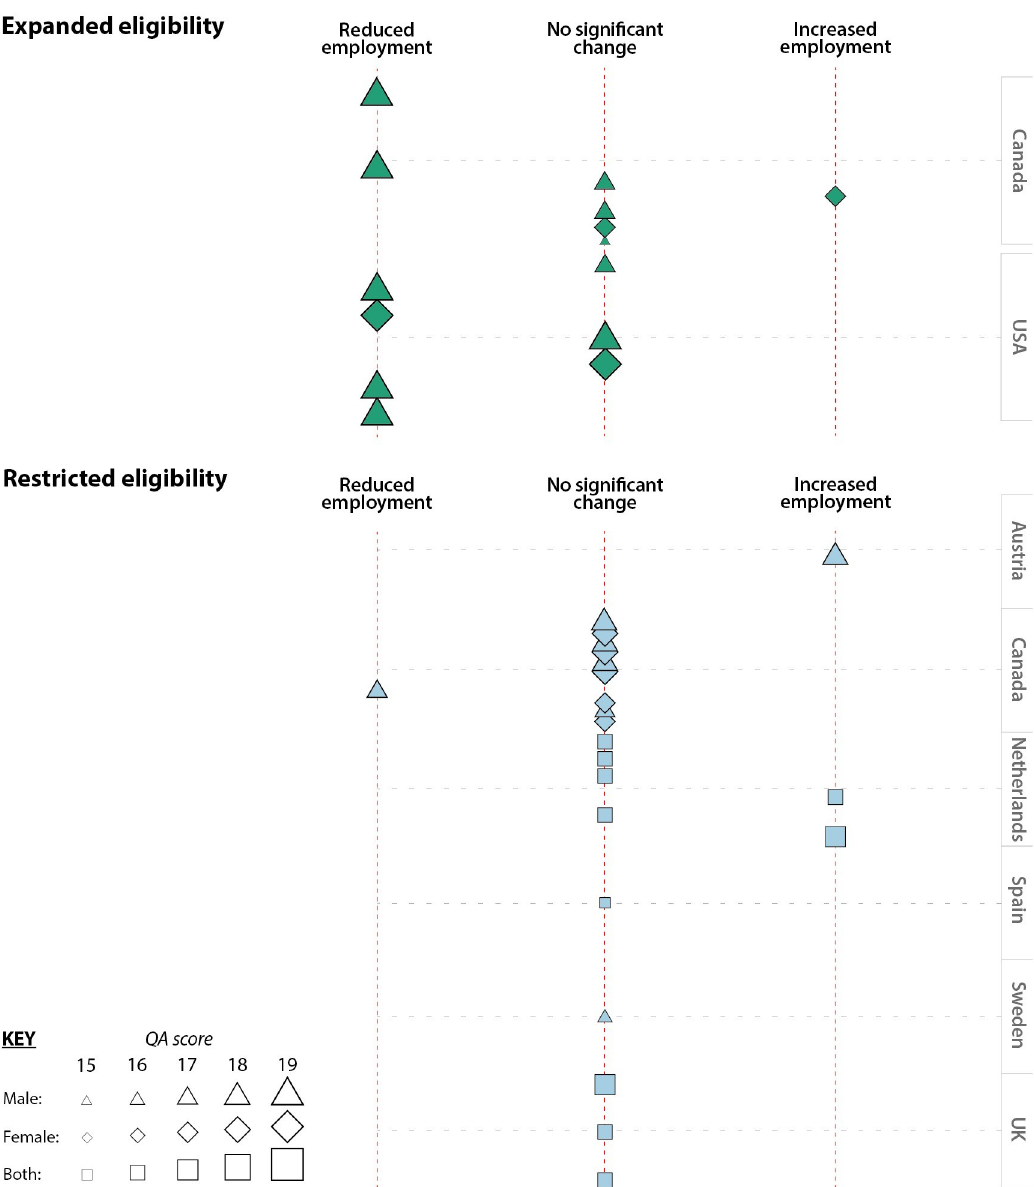
Fig 2. Harvest plot for employment outcome after reform, stratified by reform type (expansion or restriction), country, sex and QA score.